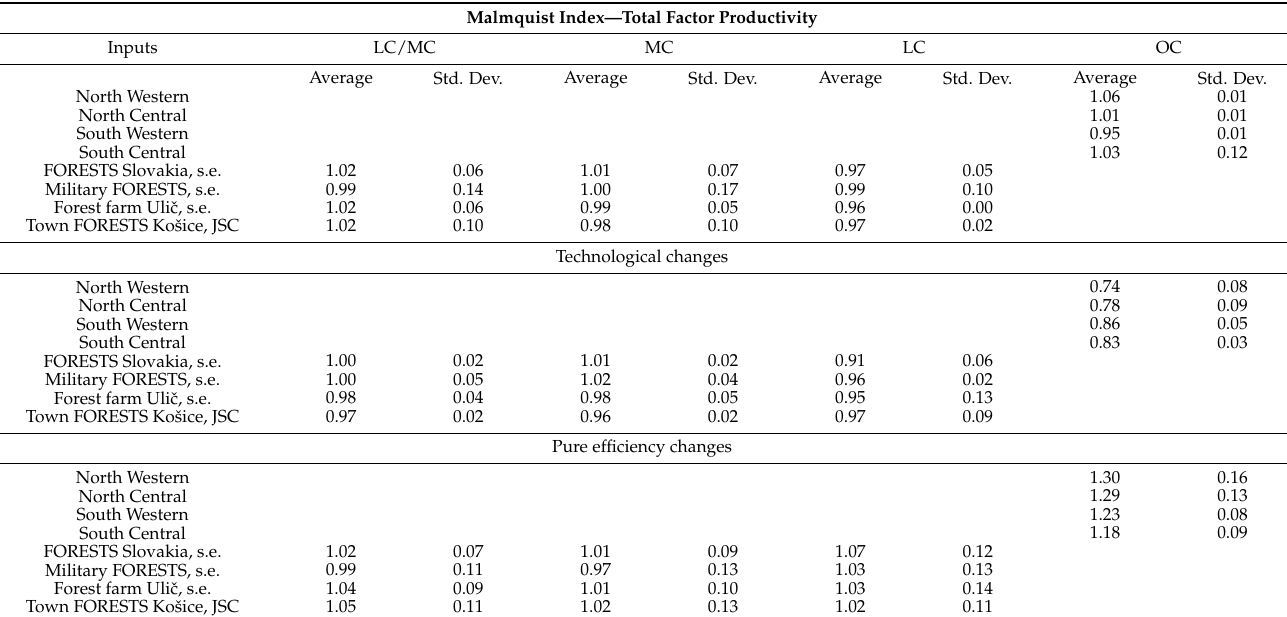
Table 6. Descriptive statistics of the Malmquist